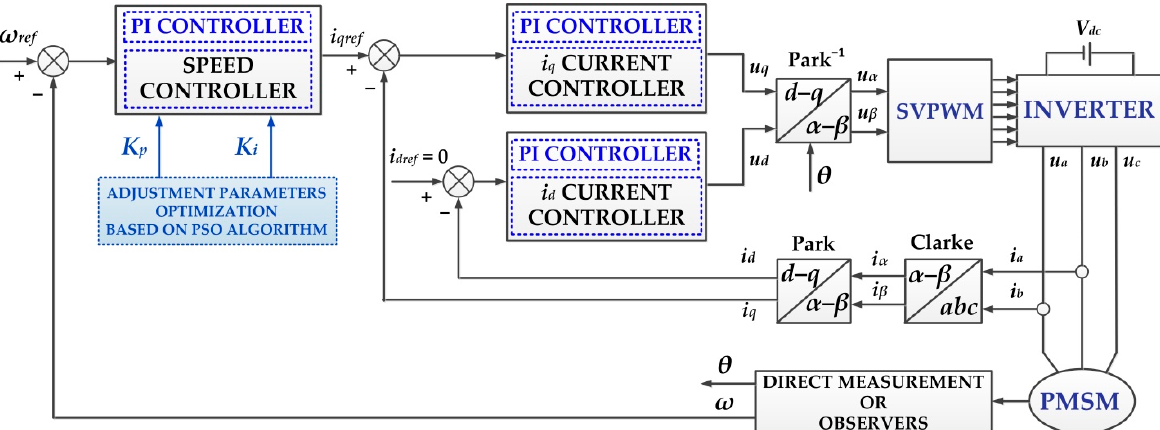
Figure 1. The control system of the PMSM based on the FOC strategy and the PI-PSO speed controller.